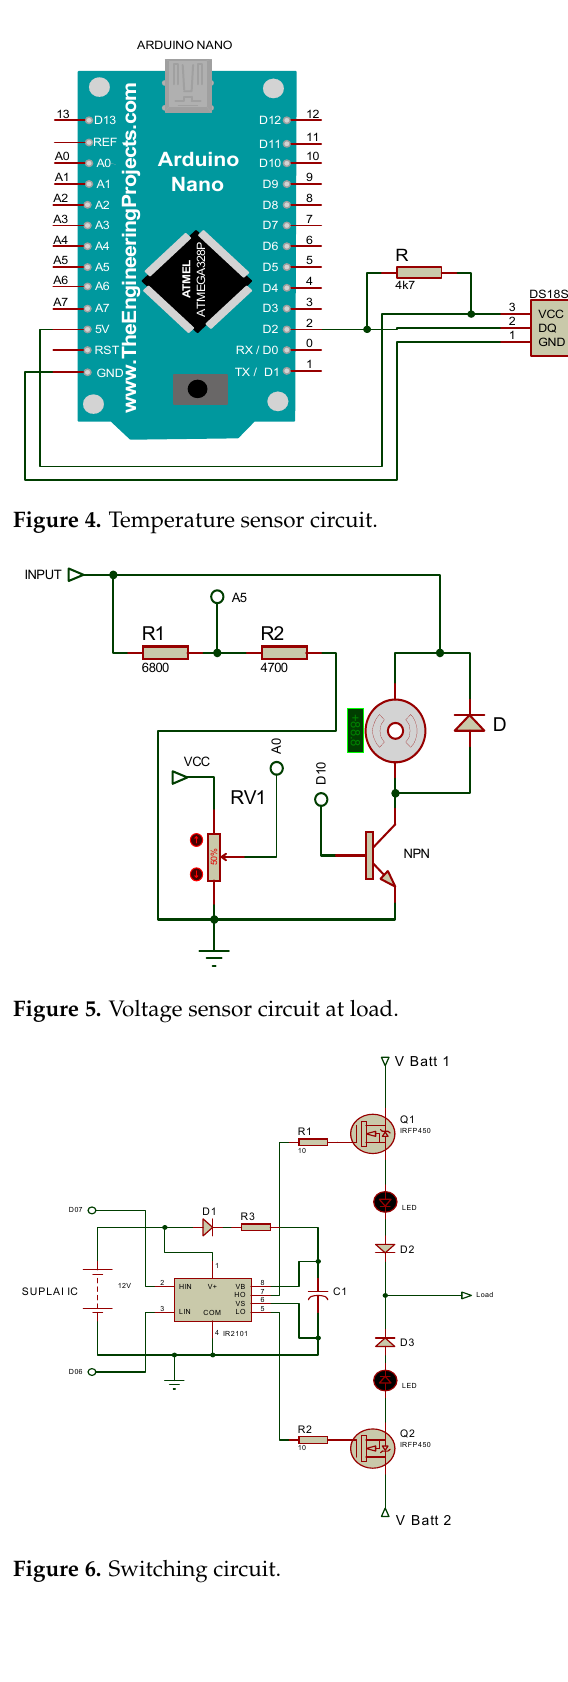
Figure 6. Switching